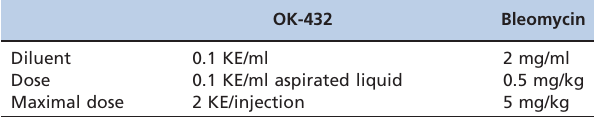
Table 2 - Doses of sclerosing